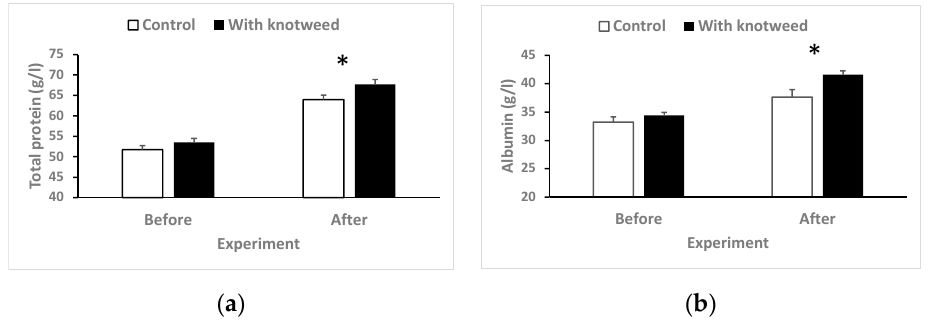
Figure 5. Total serum protein ( a ) and serum albumin ( b ) in the experimental group of pigs fed on fodder with knotweed and the control group at the beginning and the end of the experiment. Means + SEM. Difference significant on p < 0.05 marked by an asterisk.